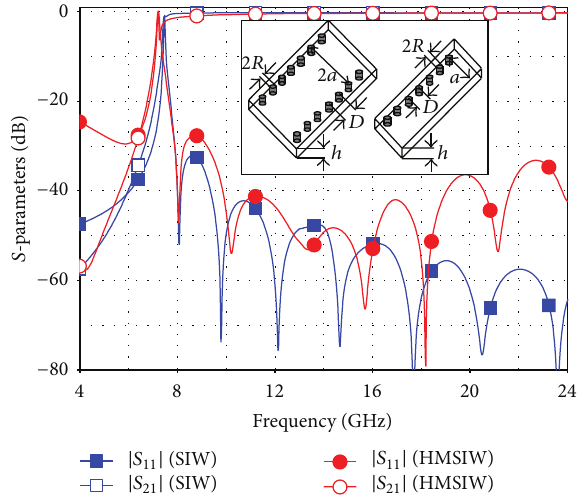
Figure 2: Comparison of cutoff frequencies and transmission characteristics of SIW and HMSIW. The geometrical parameters are 𝑎 = 7 mm, 2𝑅 = 0.5 mm, 𝐷 = 0.8 mm, and ℎ = 0.254 mm and relative permittivity 𝜀 𝑟 =